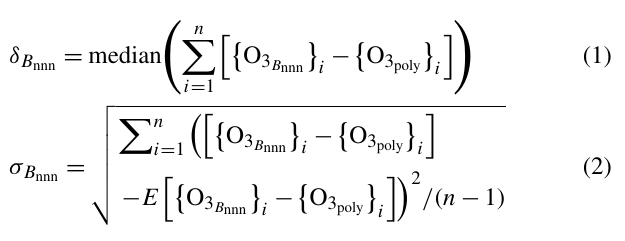
model data and E [ x ] the mean value operator. As the ozone column varies smoothly on the timescale of a few hours, the value interpolated at noon was considered the ozone column representative for that day.